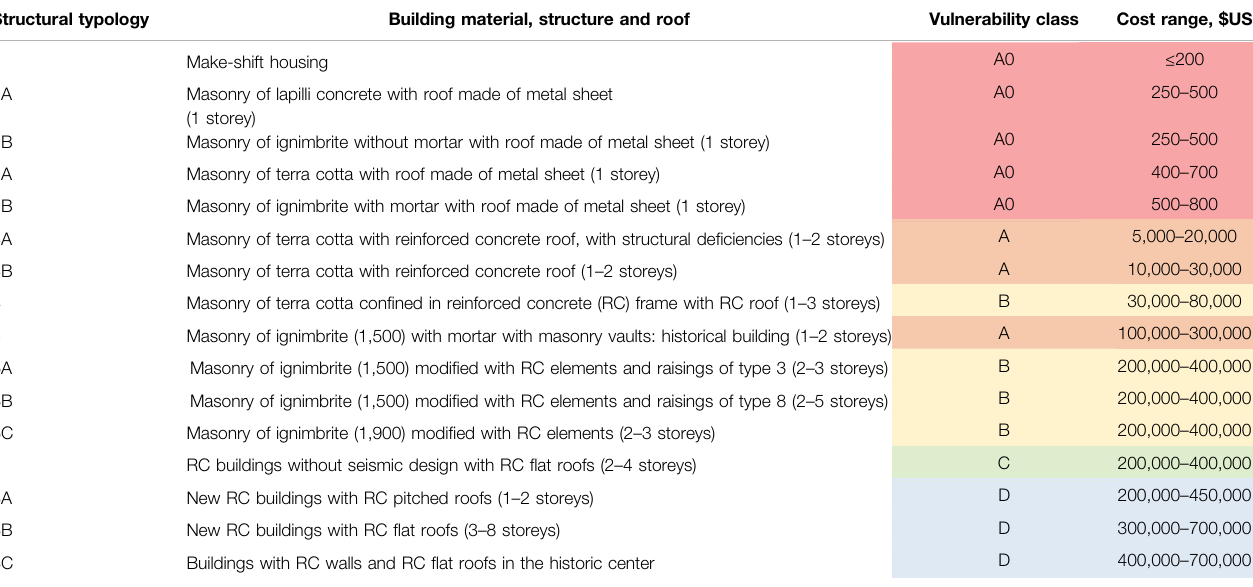
TABLE3| Classi fi cationofbuildingandrooftypes(about1,500buidlingsin3,000cityblocks)andestimatedvulnerabilitybasedonsevencriteriaindistrictsadjacenttoQda. San Lazaro and Qda Huarangal-MM (Method after the Plinius Study Centre, in: Thouret et al., 2013, 2014 for details). We added estimated cost ranges for each class based on construction or rental cost (per m 2 ) as of 2018 –